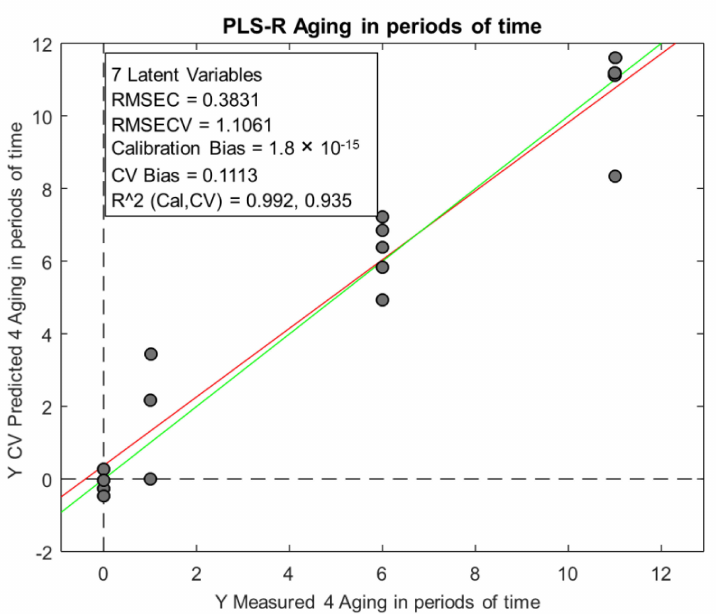
Figure 3. Plot of predicted vs. actual values for the validation